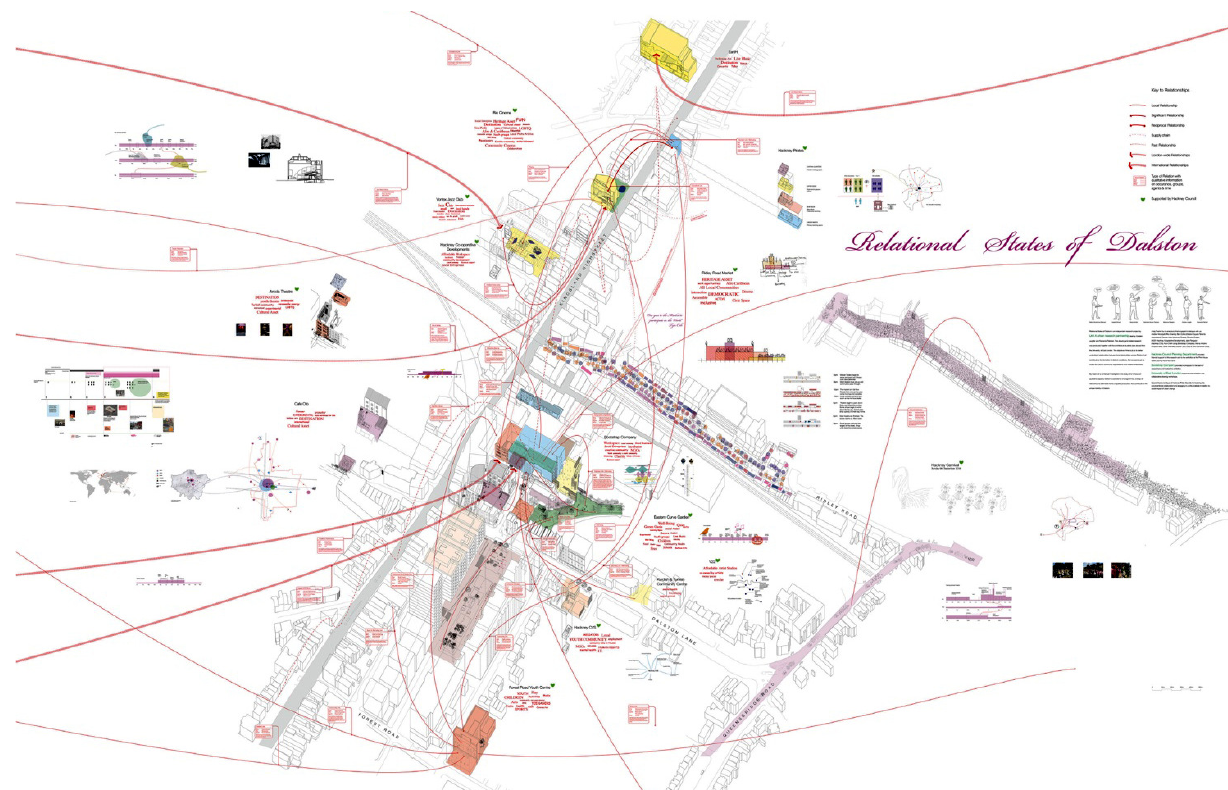
Figure 3. RSD map showing socio‐spatial relationships between 15 community stakeholders across Dalston town cen‐ tre: Axonometric drawing, original size 3.5 m by 2.4 m, third iteration, March 2019. Source: Courtesy of Unit A research